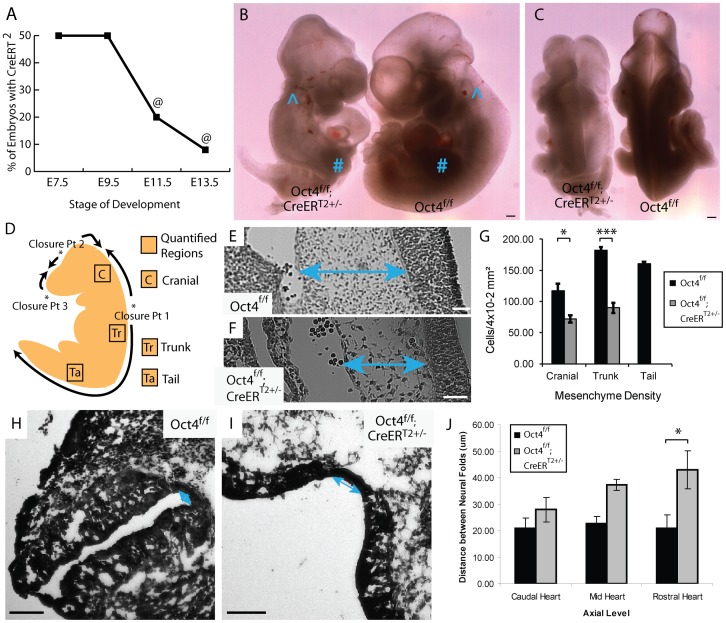
Depletion of Oct4 ∼E7.5 results in diminished viability, reduced mesenchyme density and broader spacing between the neural folds.
A The fraction (Oct4f/f;CreERT2+/−/total) embryos recovered at each developmental stage (‘@’ indicates resorbing embryos). Embryos were administered tamoxifen ∼E7.0 and ∼E7.5 (Table S1M–O). B,C Representative images of an E10.5 Oct4f/f;CreERT2+/− embryo and Oct4f/f littermate following tamoxifen administration ∼E7.0 and ∼E7.5. Features such as the otic cup (∧) and forelimb bud (#) which normally arises after NTC is initiated and turning is complete are present in both Oct4f/f;CreERT2+/− and Oct4f/f littermates. Conversely, defects in turning, somitogenesis, neural tube closure and posterior extension all fail to recover in Oct4f/f;CreERT2+/− embryos by E10.5. Scale bars in ‘B,C’ are 250 µm. B Sagittal view. C Dorsal view. D Schematic illustrating NT closure points, the directions in which the NT ‘zippers’ shut as well as the sections where mesenchyme density was quantified. E,F Representative Hematoxylin and Eosin (H and E) sections from the trunk (see ‘Tr’ in panel ‘D’) ∼E9.5. Differences in the density of mesenchyme, which is indicated with two-headed arrows, are apparent. Embryos were administered tamoxifen ∼E7.0 and ∼E7.5 and dissected ∼E9.5 (Table S1M–O). Scale bars in E,F are 50 µm. E Oct4f/f
F Oct4f/f;CreERT2+/−. G Mesenchyme, connective tissue comprised of mesoderm and neural crest cells, has a lower density in Oct4COND MUT. The average density within 4×10−2 mm2 ±s.e.m. (200 µm×200 µm) from sections equivalent to those in panel ‘E,F’ is plotted (F1,13 = 54.60, p<0.05 2-way ANOVA, *p<0.05, ***p<0.001 Bonferroni posttest). Due to the posterior truncation, insufficient mesenchyme was present in the tail of Oct4COND MUT to quantify. H–J The neural tube in H Oct4f/f
I Oct4f/f;CreERT2+/−. Scale bars in ‘H,I’ are 100 µm. J The distance between neural folds in the trunk of Oct4f/f;CreERT2+/− is broader (F2,22 = 17.42, p<0.05 2-way ANOVA, **p<0.01 Bonferroni posttest. Embryos in ‘H–J’ were administered tamoxifen ∼E7.0 and ∼E7.5 and dissected ∼E9.5 (Table S1M–O).